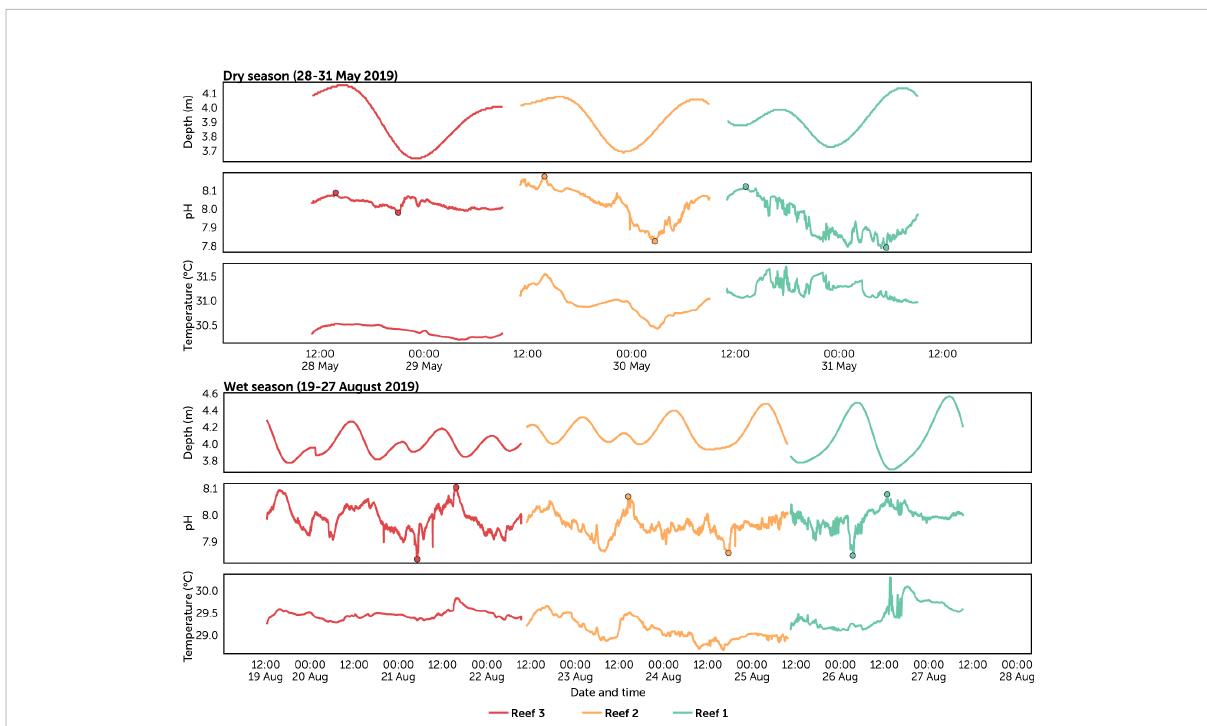
FIGURE 4 Predicted tide level, pH and temperature time series recorded in each reef per season. Circles represent the amplitude (lowest and highest) pH values for each reef per season.